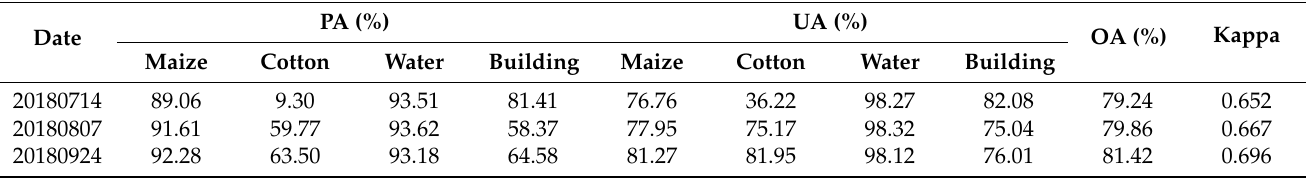
Table 5. Accuracies and Kappa coefficients of the classification of 4 land-cover types using 33 polarization decomposition features and the random forest